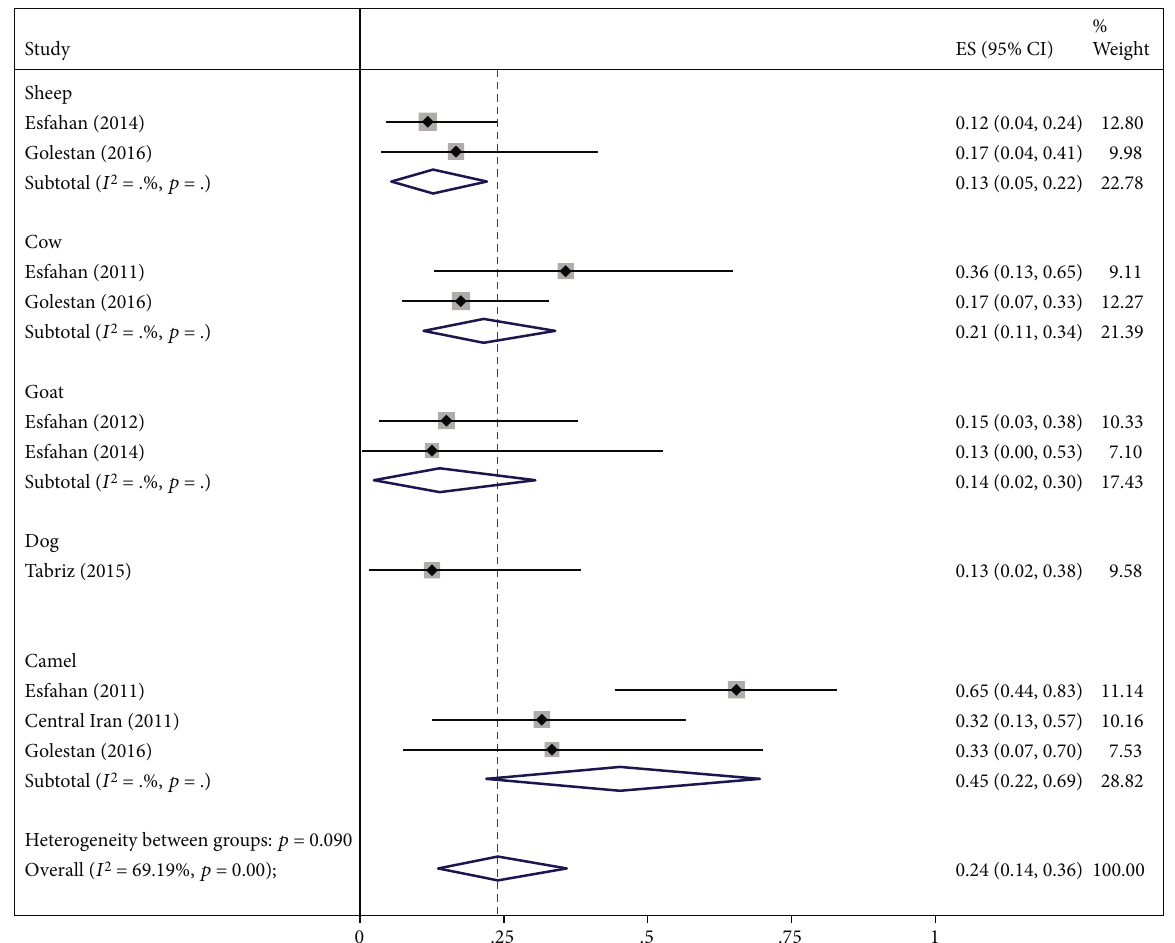
Figure 11: Forest plot of subgroup analysis of studies on cystic echinococcosis G